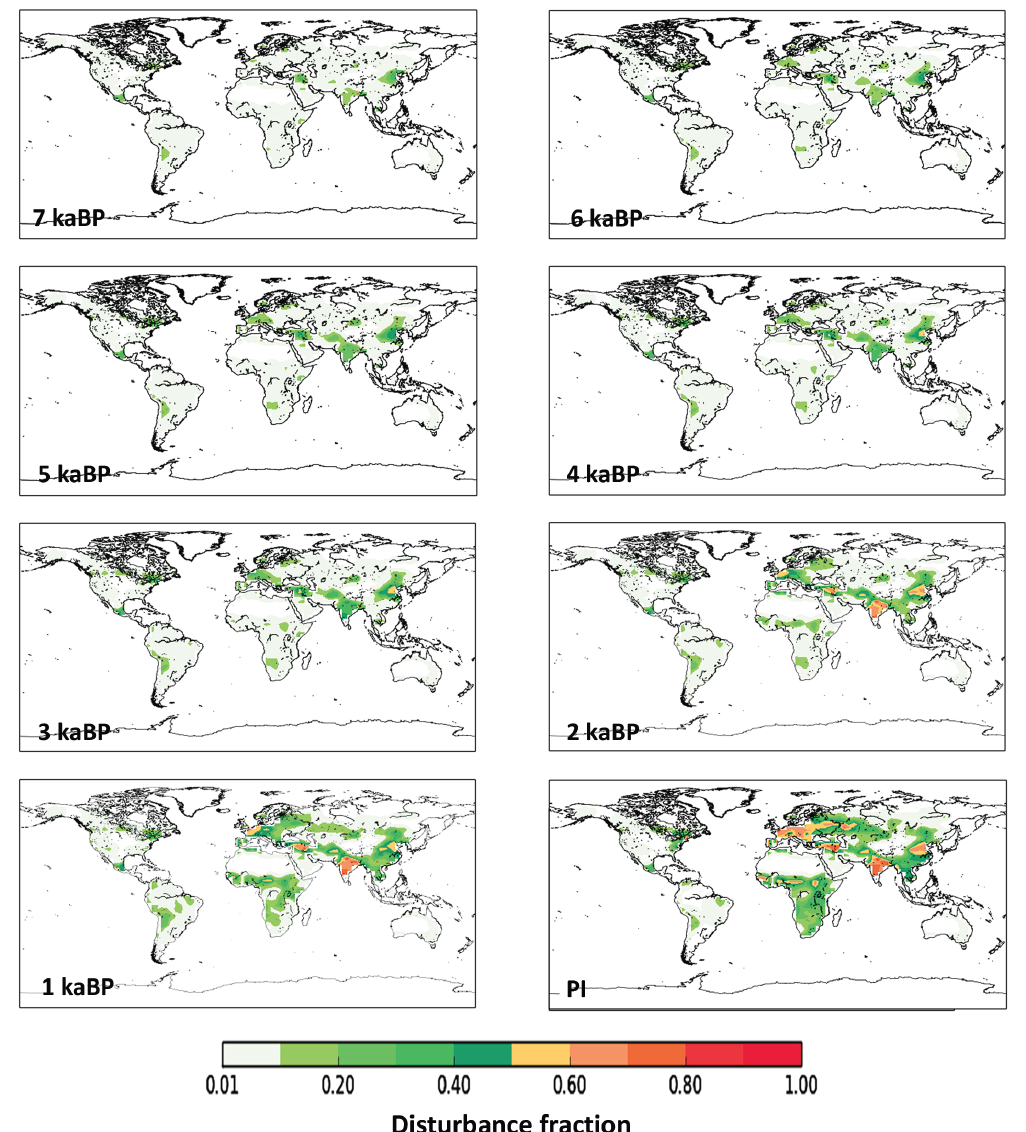
Figure 1. Fraction of anthropogenically disturbed land at 1000-year intervals from the late pre-industrial (1850CE) period to 7kaBP. The land disturbance data are based on the anthropogenic land use scenario KK10 (Kaplan et al., 2009,